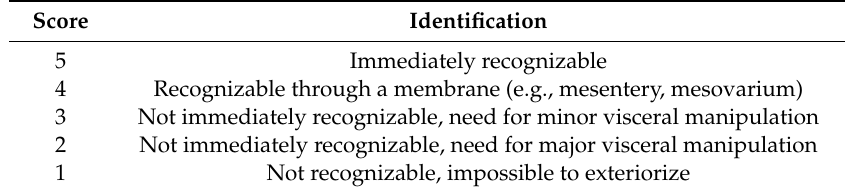
Table 2. Scoring system for ease of identification of the ovary opposite to the surgical incision, modified from Divers et al., 2010.